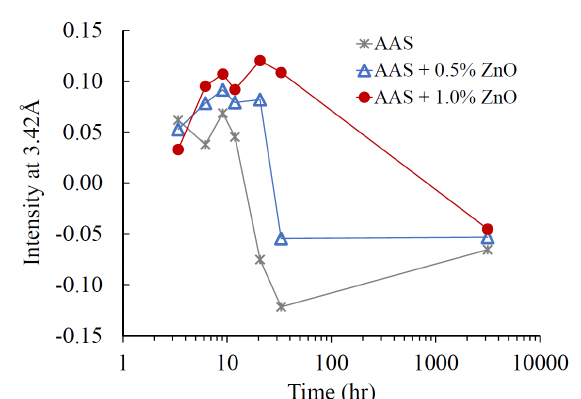
Figure 4. Intensity of the difference curves (see Figure 3) at 3.42 Å as a function of the reaction time for neat alkali ‐ activated slag (AAS), and AAS with 0.5% and 1.0% nano ‐ ZnO. The difference curves were obtained by subtracting the initial curve (0.9 hr) from the curve at the designed